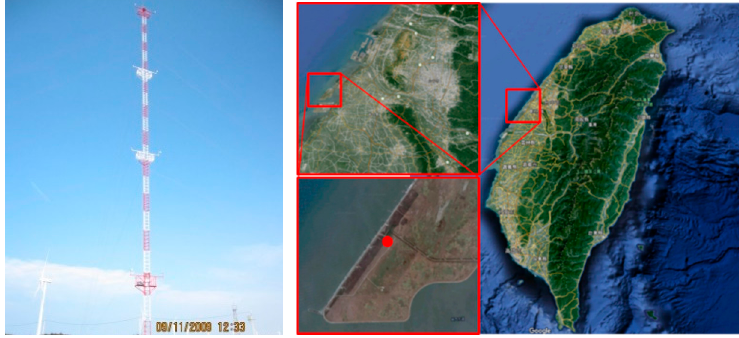
Figure 2. Meteorological mast on the Zhangbin coastal area.